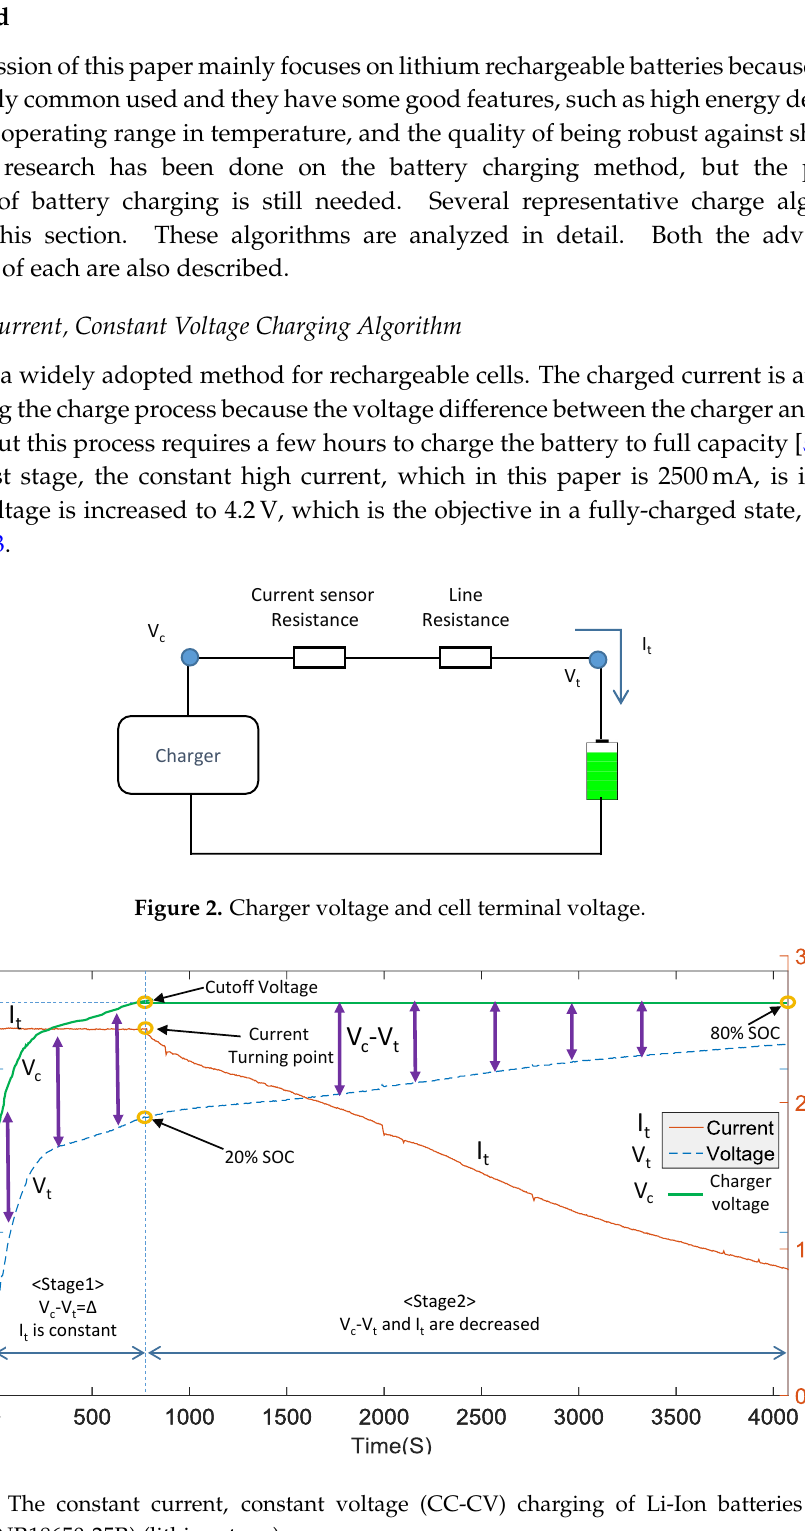
Figure 3. The constant current, constant voltage (CC-CV) charging of Li-Ion batteries (model: Samsung INR18650-25R) (lithium